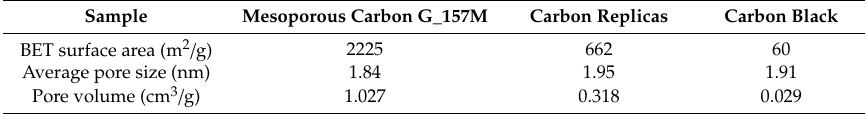
Figure 2. XRD patterns of LTO ( a ), LTO/5%CB ( b ), LTO/20%CB ( c ), LTO/5%CR ( d ), LTO/20%CR ( e ), LTO/5%G_157M ( f ), and LTO/20%G_157M ( g ). Table 2. BET surface area and average pore size of the carbonaceous